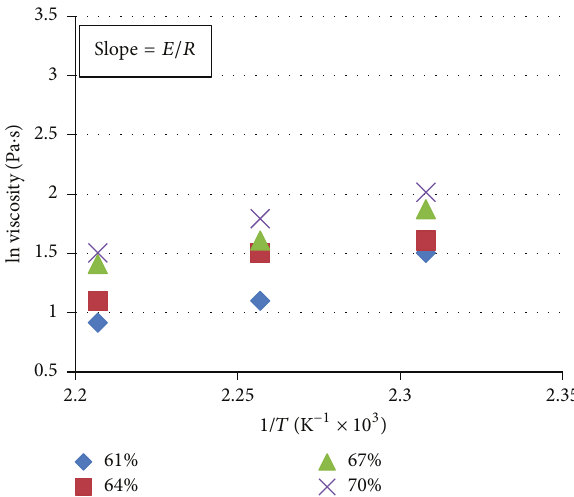
Figure 9: A relationship between viscosity and temperature for various P25/75